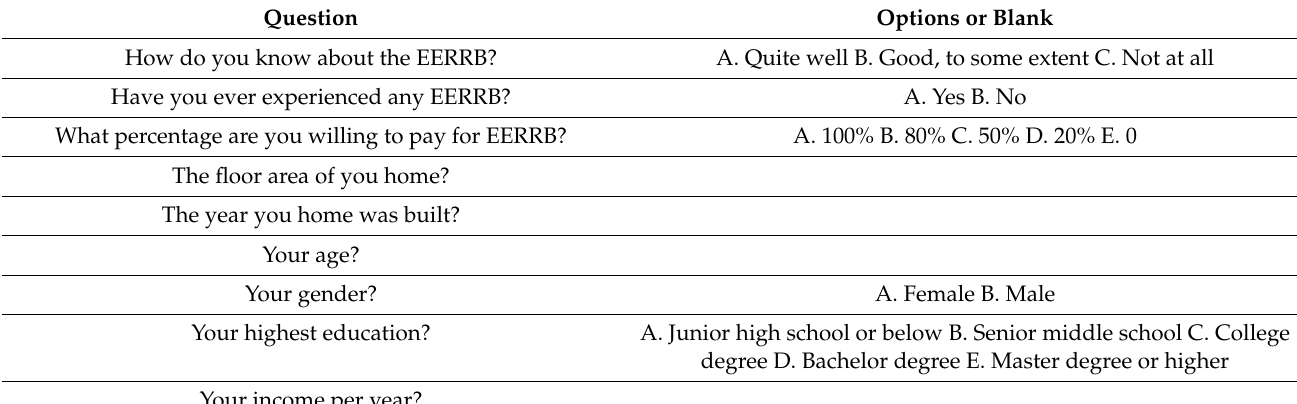
Table A2. Questions in